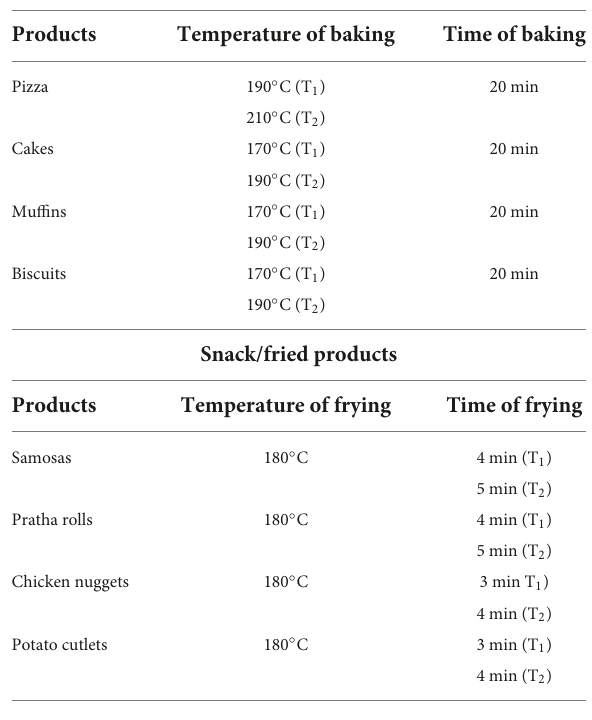
TABLE 9 Treatment plan of different bakery and snack/fried products prepared under various time and temperature